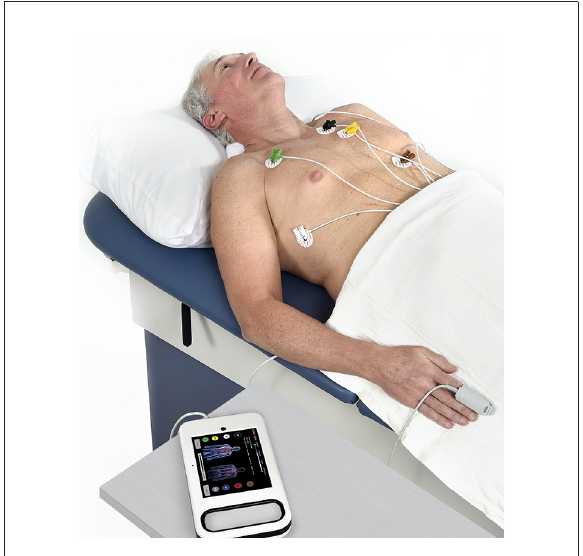
FIGURE1 Signal acquisition using the CorVista Capture, with the electrodes placed on the torso (electrode on the back not visible), and the PPG clip placed on the